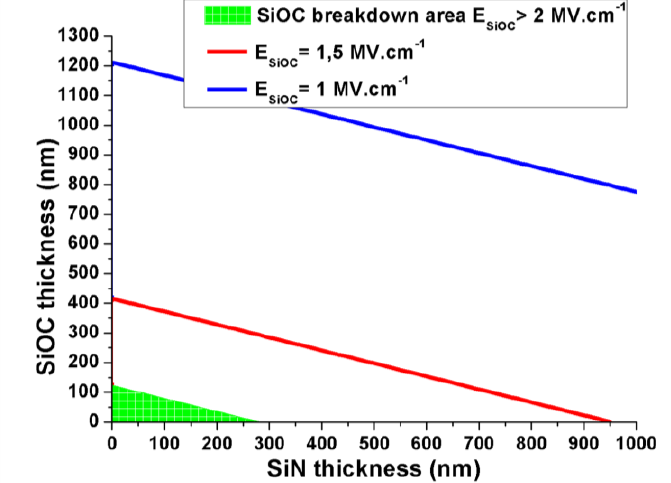
Figure 7. Diagram (dSiN ; hSiOC) illustrating the breakdown area given the dielectric breakdown electric field of the hydrophobic SiOC layer. The electric field breakdown considered for the SiOC is 2 MV cm −1 . ESiOC represents the electric field in the SiOC layer. Calculations are carried out at V = Vth and f = 1 kHz for an ultra-pure water liquid finger actuation with w = 20 µm and g = 10 µm.